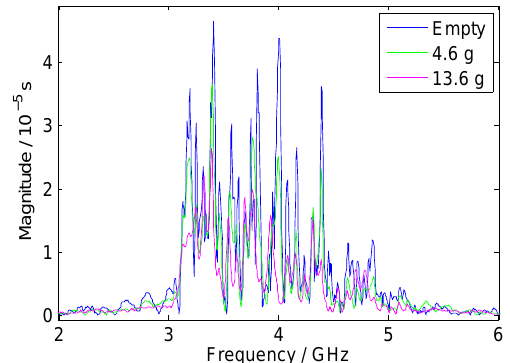
Figure 11. Maximum and average values of the smoothed en- velopes (Fig. 9).